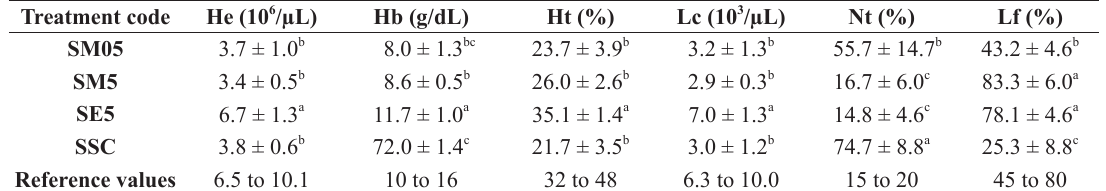
* Treatment code described in Table 1. He = erythrocyte, Hb = hemoglobin, Ht = hematocrit, Lc = total leukocyte, Nt = neutrophil (segmented), Lf = lymphocyte. Reference values = values within the normal range for mice (Thrall, 2007). Different letters indicate statistically significant difference among the treatments according to Scott-Knott’s test (P ≤